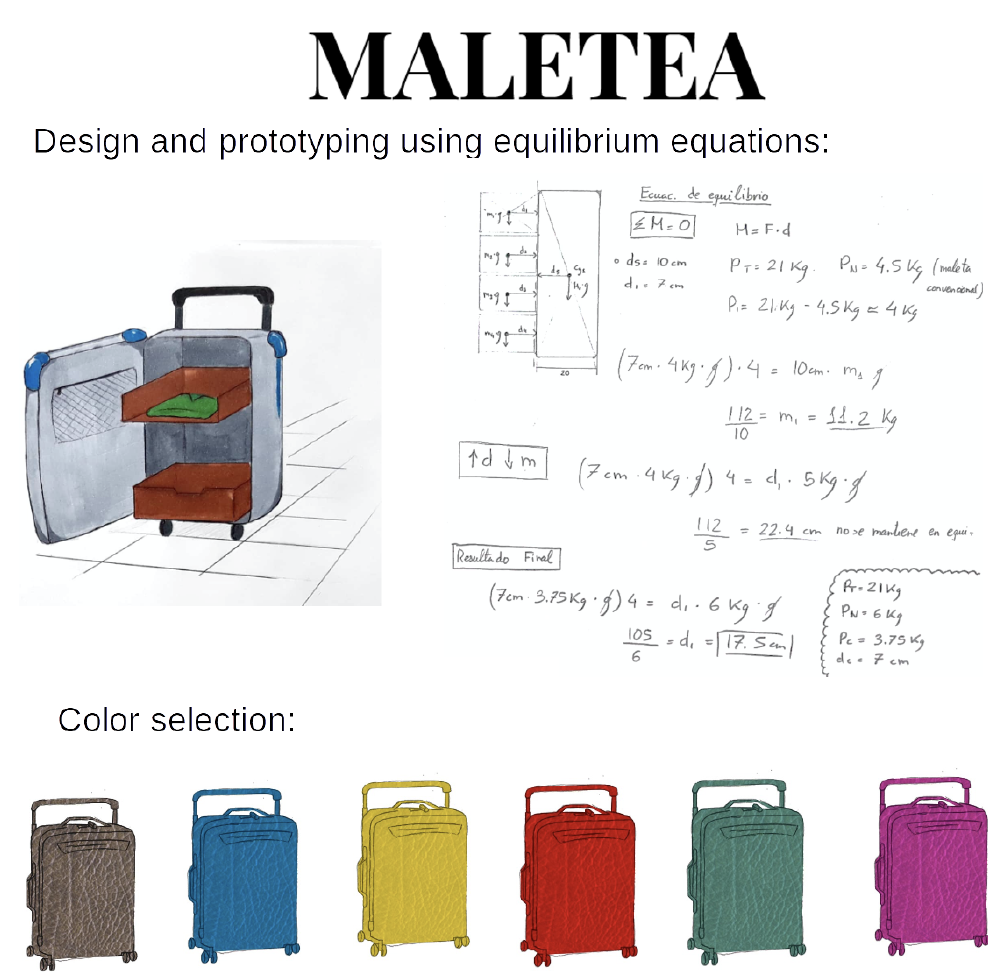
Figure 7. Example of one of the results of Milestone V. The